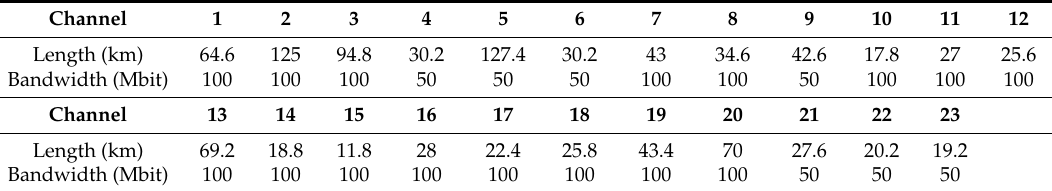
Table A1. Communication system data of IEEE39.